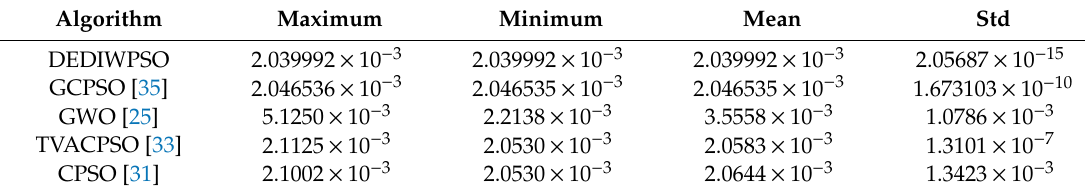
Table 11. Comparsion of the obtained RMSE for the double-diode module.